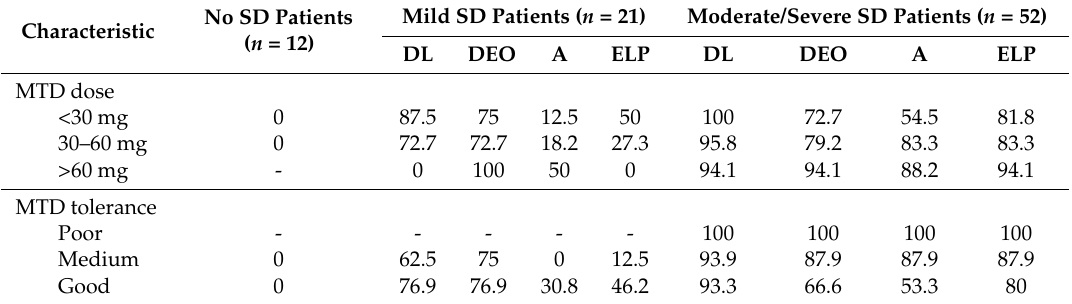
Table 4. Effect of MTD dose and tolerance on the frequency (%) of sexual dysfunction